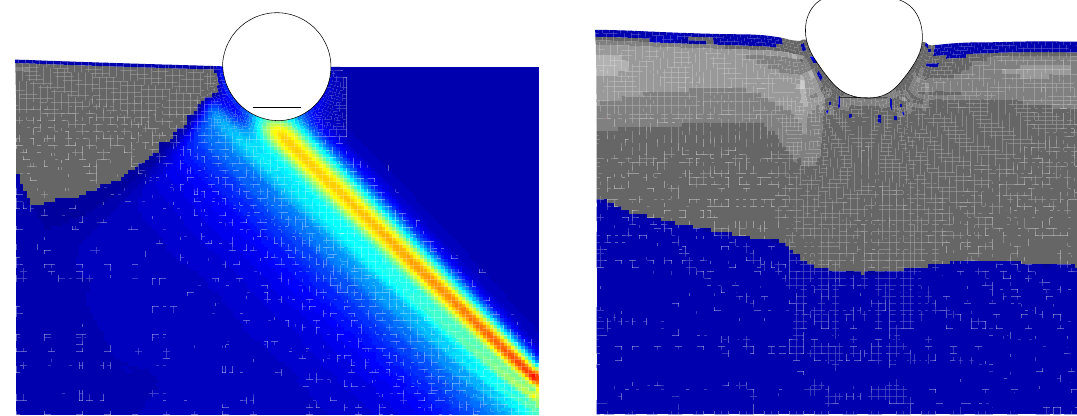
Fig. 3. Pressure/cavitation contours and deformations for 8 ms. Fig. 4. Pressure/cavitation contours and deformations for 22 ms.